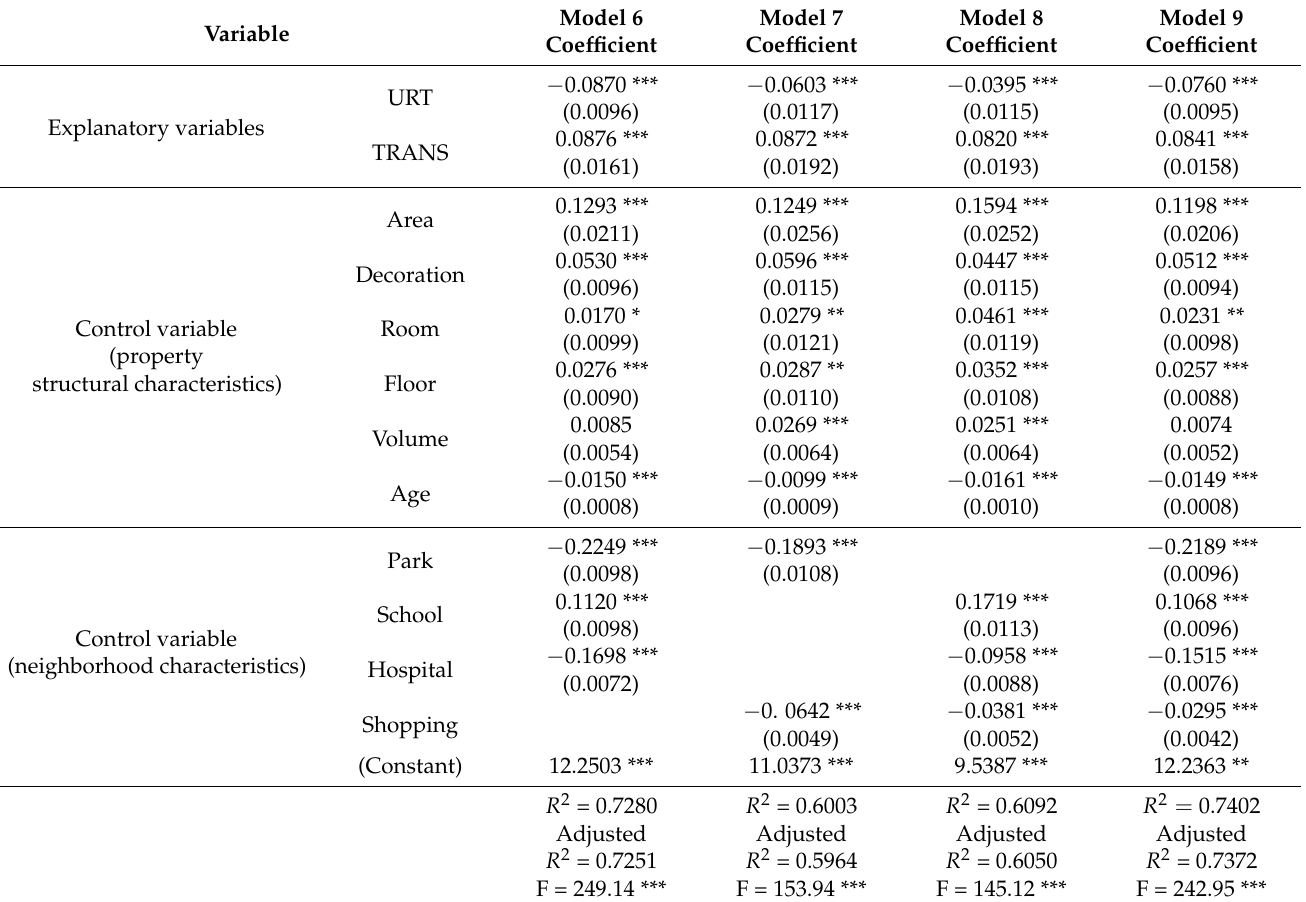
Table 4. The results of the combination effects of neighborhood infrastructure and URT on property